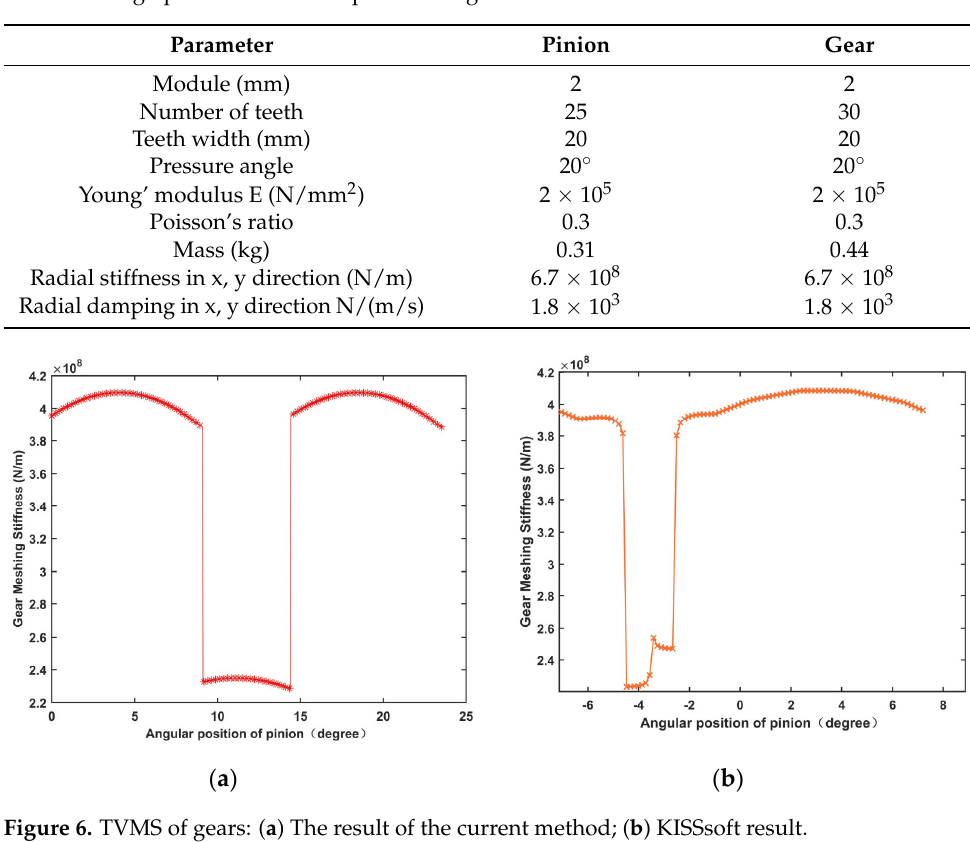
Table 2. Design parameters for the pinion and gear.